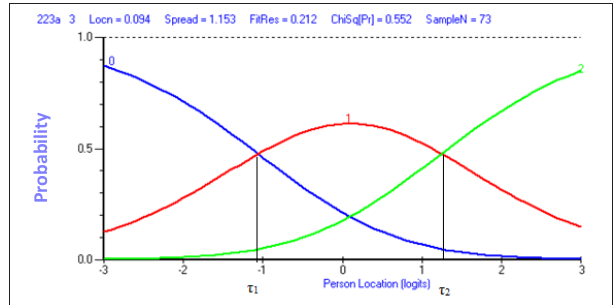
FIGURE 1: Category probability curves (Item Figure 1 models the conditional probability of a score of 0, 1 or 2 for a polytomous item (Item 2.2.3a) with three